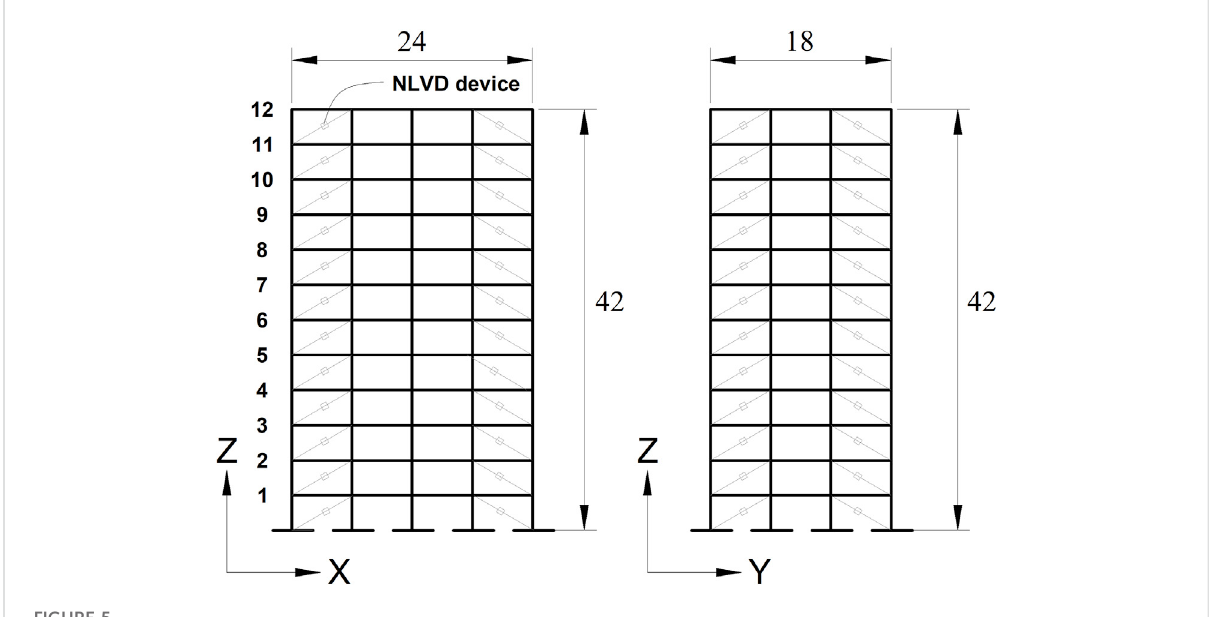
FIGURE 5 Elevation view of the buildings fi tted with NLVD (units in